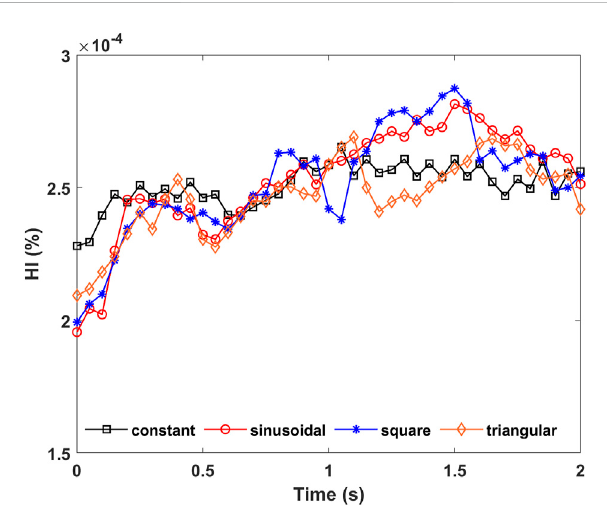
Time – course mass-weighted average HI values at pump ’ s outlet under constant, sinusoidal, square, and triangular speed modulation